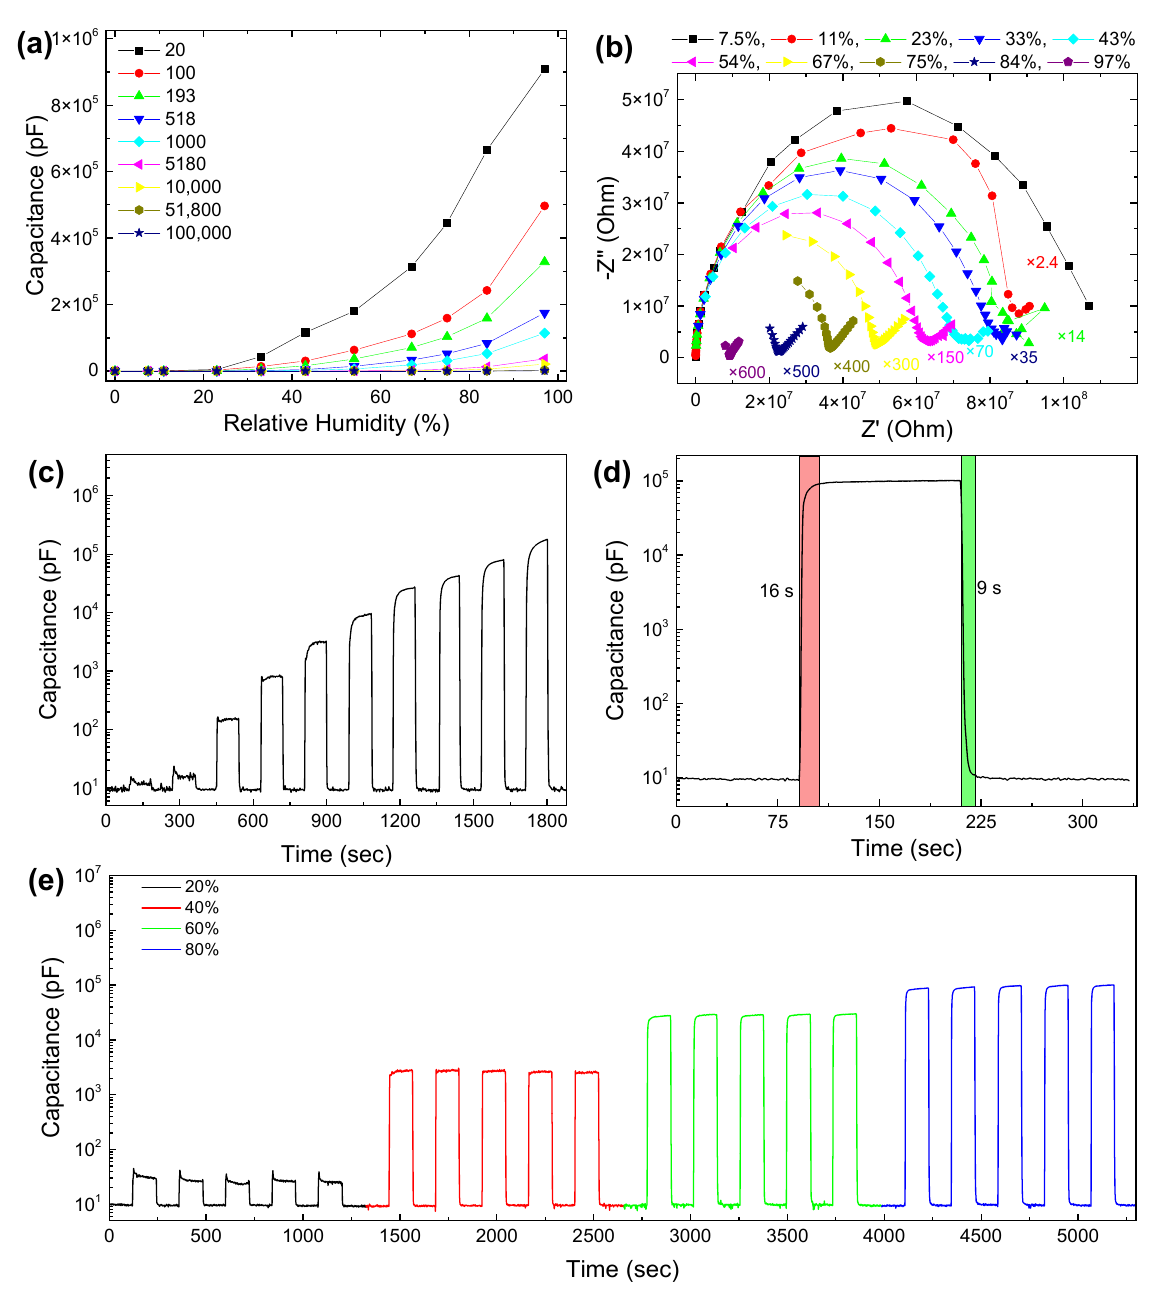
Figure 2. Performance characteristics of the LIG/GO 0.33mg/mL interdigitated electrode humidity sensor. ( a ) Capacitance vs. relative humidity for various frequencies; ( b ) complex impedance plots at varied RH levels; ( c ) dynamic response vs. relative humidity at 500 Hz; ( d ) response and recovery of the sensor vs. 80% RH @ 500 Hz; ( e ) repetitive absorption and desorption curves for 0–20%, 0–40%, 0–60%, and 0–80% RH. All the measurements were performed at 500 mV. The sensor displayed a good capacitance response even at low RH values. From 0 to The occurrence of these processes was also monitored by impedance 11% RH, the capacitance rose from 9.5 pF to 14.8 pF. The high initial resistance of the GO film was responsible for the sensitivity observed at low RH. Water molecules strongly